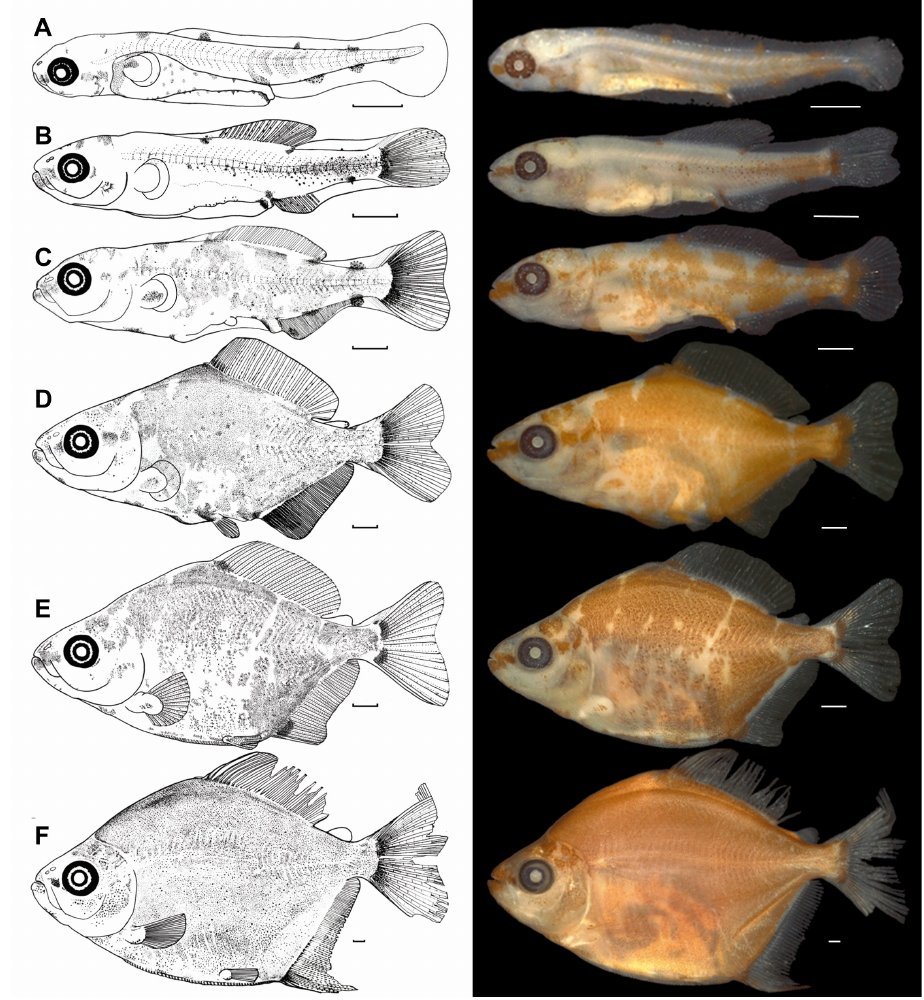
FIGURE 1 | Larval and juvenile development of Myloplus asterias : A. Preflexion (8.6 mm); B. Flexion (8.7 mm); C. Early of postflexion (10.7 mm); D. Postflexion (15.1 mm); E. End of postflexion (21.5 mm); F. Juvenile (35.2 mm). Scale bar = 1